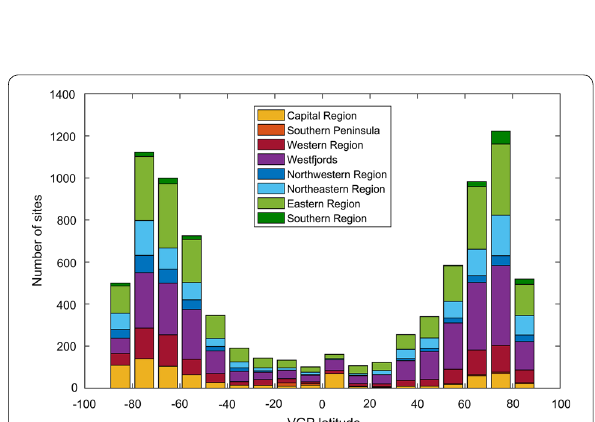
Fig. 12 Histogram of sites by VGP latitude. Distribution of ICEPMAG sites by VGP latitude, coloured by geographic region (legend